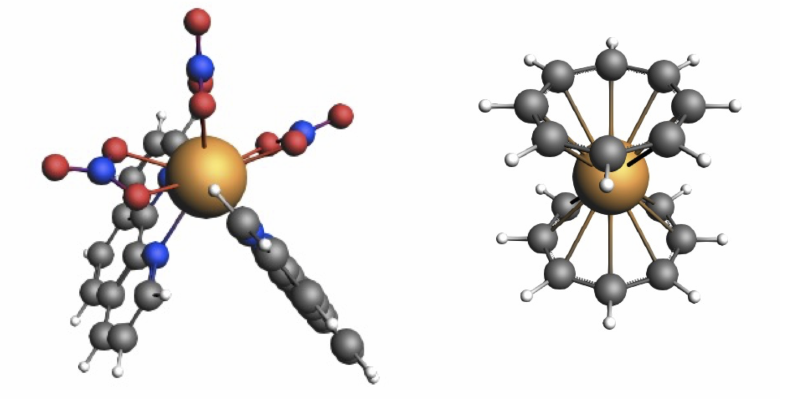
Figure 1. Ball-and-stick molecular model of the structures of [Eu(NO 3 ) 3 (phenanthroline) 2 ] (left-hand- side) and cerocene (right-hand-side). Color code: grey (carbon), red (oygen), white (hydrogen), blue (nitrogen), and Orange (Europium and